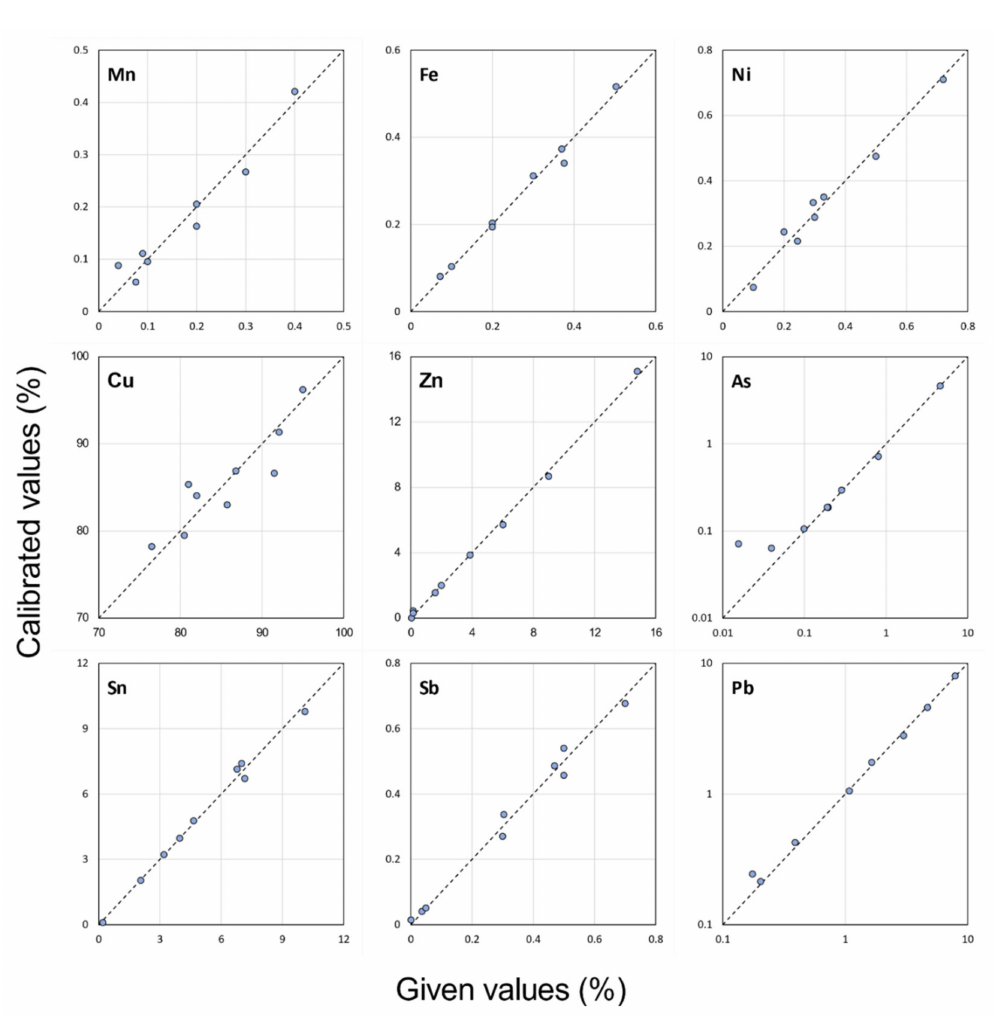
Figure A1. Scatterplots of given versus calibrated values for the reference standards. The dashed black lines show the ideal 1:1 x-y line. As and Pb are shown with logarithmic axes. In the case of three elements (Ni, Sb and Pb) slightly negative values were occasion- ally obtained from the calibration. Examination of typical spectra indicates that, at low concentrations, the peaks for these elements are swamped by the tails of the much larger Cu K α and K β peaks at low concentrations (Figure